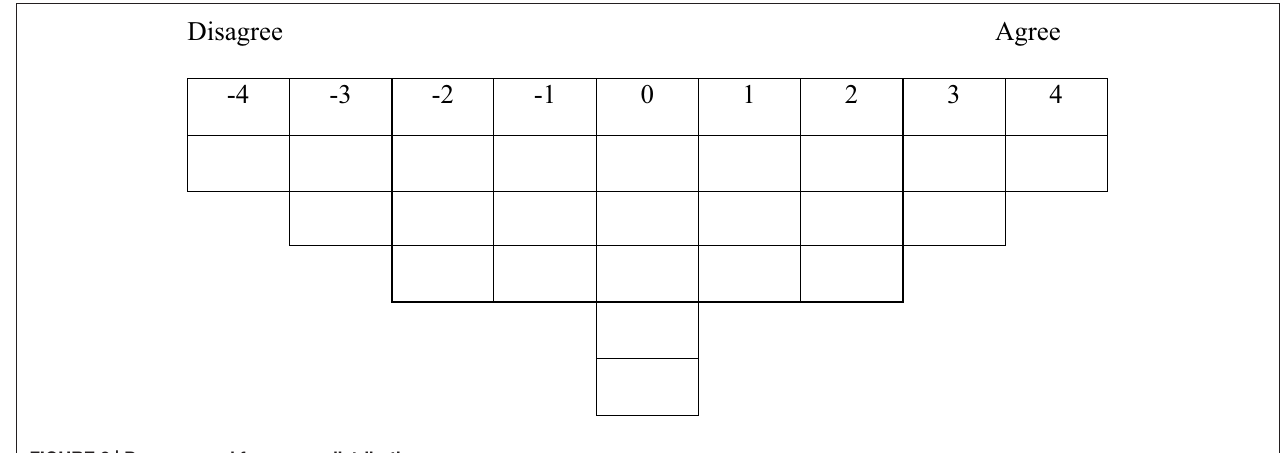
FIGURE 2 | Pre-arranged frequency